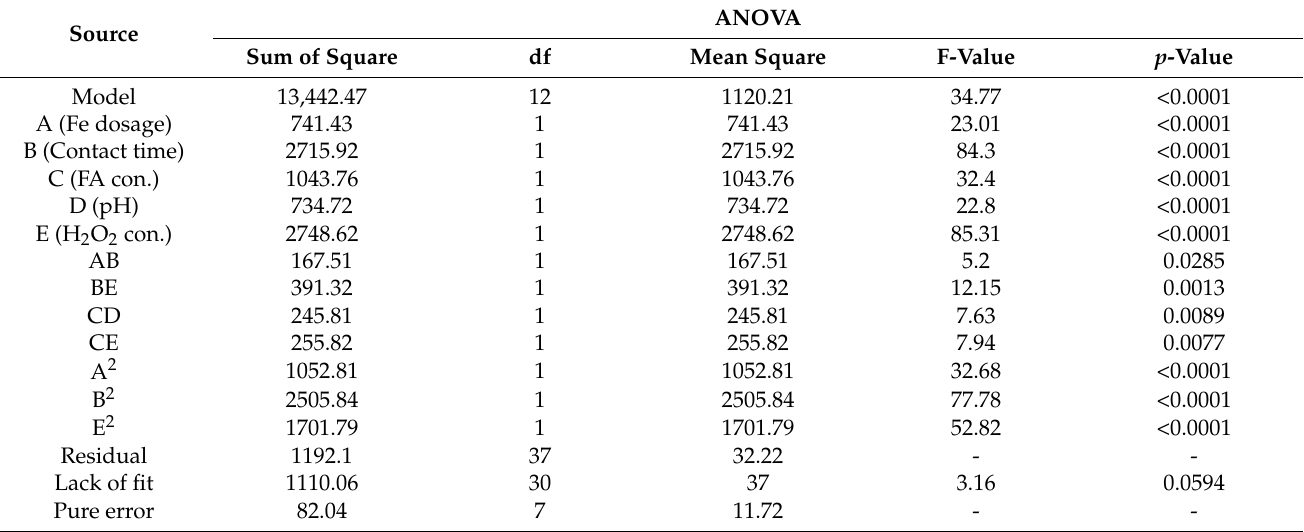
Table 4. The results of the ANOVA, as well as the coefficient significance of the model parameters.